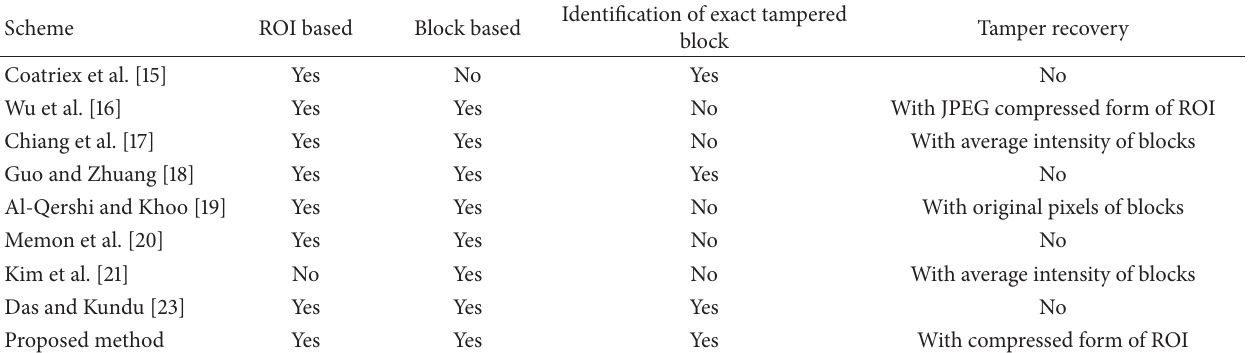
Table 6: Performance